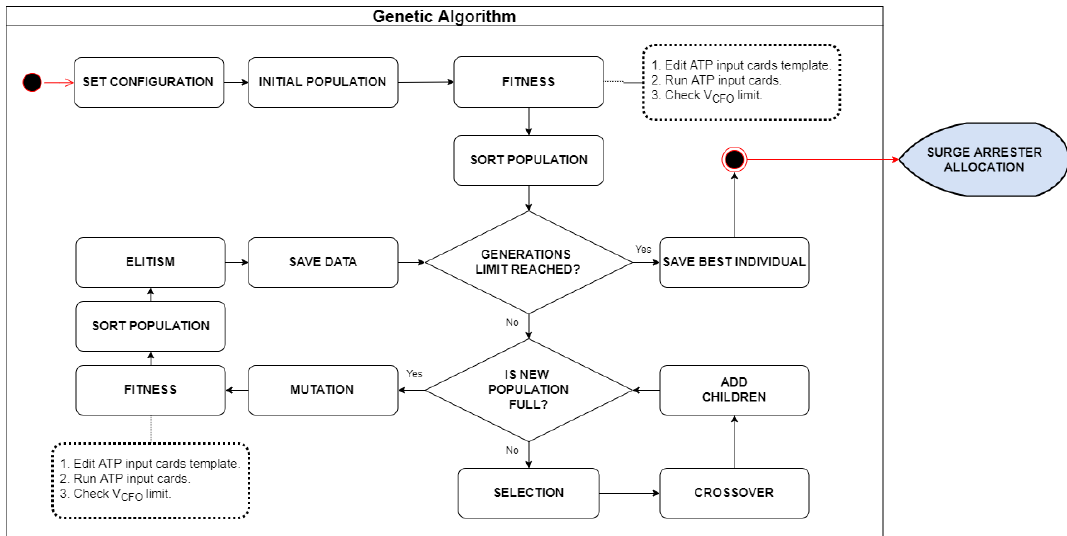
Figure 3. Genetic algorithm